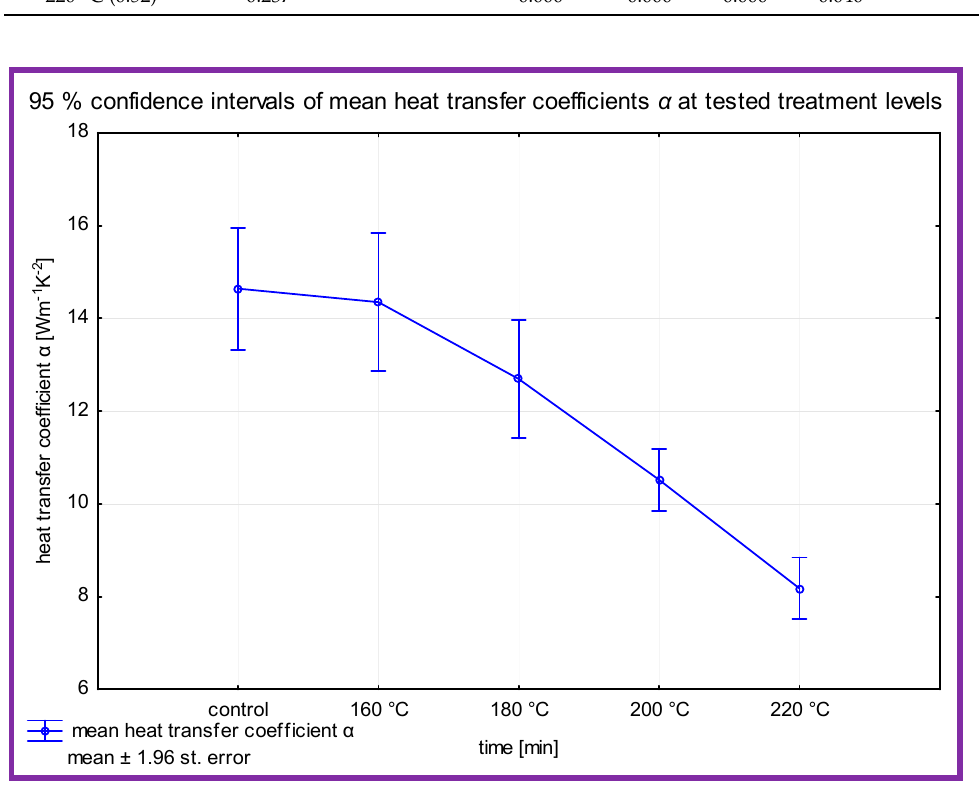
Figure 6. Dependences of the heat transfer coefficient on the heating time samples.